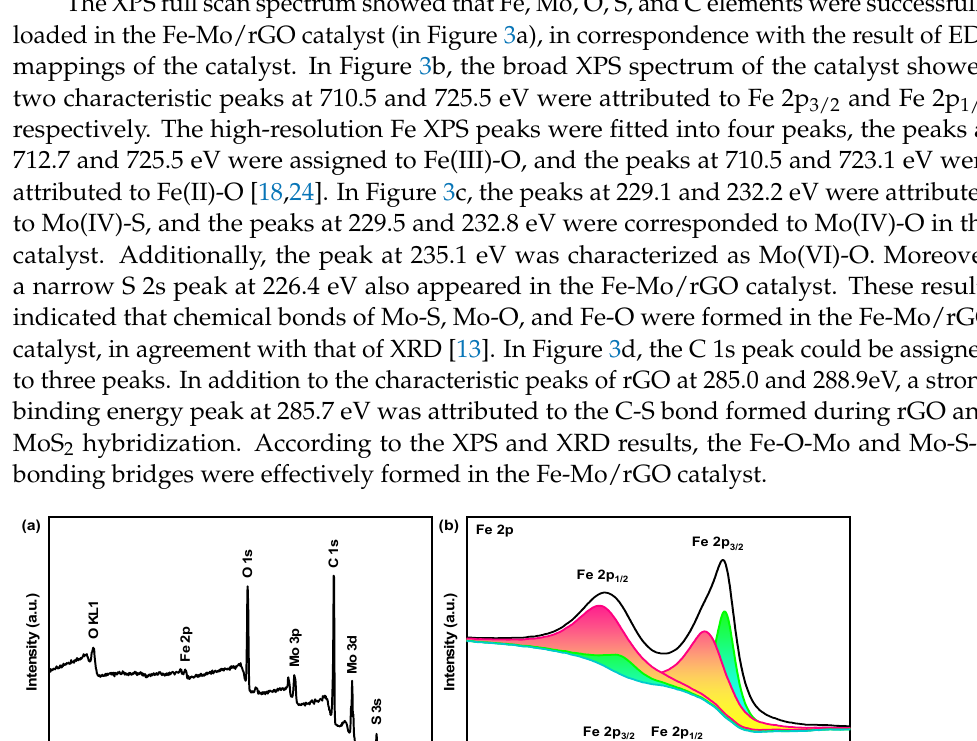
Figure 4 revealed the SMT degradation efficiency over different catalysts near neutral pH value at room temperature (RT) in the Fenton-like reaction. H 2 O 2 alone hardly de- graded the SMT, and the rGO and Fe/rGO samples also showed less than 5% SMT removal in 30 min. The result indicated that H 2 O 2 could not be effectively activated by rGO and Fe/rGO catalysts to remove SMT near neutral pH value. The Mo/rGO catalyst exhibited ca. 30% SMT removal in 30 min. Notably, as high as 78% SMT degradation efficiency was achieved over the Fe-Mo/rGO catalyst in 15 min. The pollutant degradation followed the pseudo-first kinetics over different catalysts (in Figure 4b). The apparent kinetic constant ( k ) of the Fe-Mo/rGO catalyst (0.2156 min − 1 ) was ca. 13 and 96 times higher than that of the Mo/rGO and Fe/rGO catalysts, respectively. In addition, the Fe ion leaching of Fe-Mo/rGO catalyst was ca. 0.9 mg/L in the reaction, and almost no Mo ion leaching was detected. The homogenous Fe 2+ , as a catalyst, was investigated for the SMT degradation near neutral pH value in the presence of H 2 O 2 . It was found that ca. 10% SMT removal was obtained over Fe 2+ ion in the reaction and was far lower than that over the Fe-Mo/rGO heterogamous catalyst. The above results demonstrated that the Fe-Mo/rGO catalyst had a better cata- lytic performance for the SMT degradation at near neutral pH value. Generally, there were abundant inorganic anions in water and wastewater, which could react with ROS and affect the degradation of pollutants [14,25]. Therefore, the per- formance of the Fe-Mo/rGO catalyst for SMT removal near neutral pH value were evalu- ated in the presence of inorganic anions ([Cl − ] = [SO 42 − ] = [HCO 3 − ] = 0.076 mM). As reported previously, ·OH oxidized SO 42 − and Cl − to generate other radicals with a lower oxidation potential, and HCO 3 − quenched ·OH to produce non-reactive HCO 3 · [19], resulting in a decrease in the pollutant degradation. As shown in Figure 4c, a slight reduction in the SMT removal was observed in the presence of different inorganic anions, and the inhibi- tion was in the order of Cl − < SO 42 − < HCO 3 − . The result indicated that the performance of the Fe-Mo/rGO catalyst was not obviously interfered with by inorganic anions in the re- action. To further evaluate the performance of the Fe-Mo/rGO catalyst, Figure 4d and Table 1 showed the SMT removals of different catalysts reported in the literature under mild